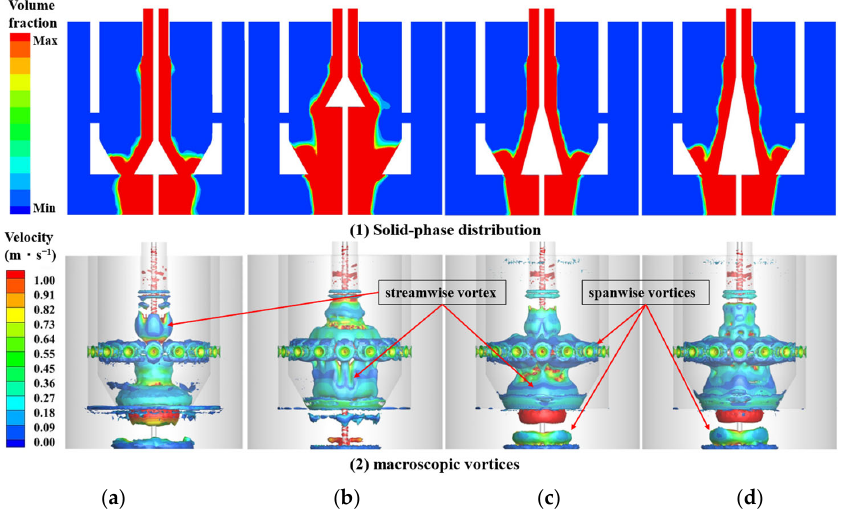
Figure 11. Evolutionary characteristics of macroscopic vortices in the feedwell with different types of deflectors: The red areas in (1) indicates the main distribution range of the solid phase. ( a ) α a = 60°; ( b ) α b = 60°, with the bottom height of the conical deflector of ( b ) being 1766 mm higher than that of ( a ); ( c ) α c = 30°; and ( d ) α d = 21.1°.